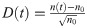
Shorter timescale results.Variance in species abundances over time, for different parametrizations of the specialist scenario. Vertical axis plots the variance across histories of the stochastic process of D(t)=n(t)-n0n0, which is then averaged across species with different initial abundances n0 (bands show standard error of the mean). Colors show parametrizations with increasing non-neutrality index (NNI), with lines showing the loess regression with smoothing parameter set to 1. Black line shows neutral prediction. Inset highlights similarity of all curves except NNI = 1 at timescales up to 10 generations.